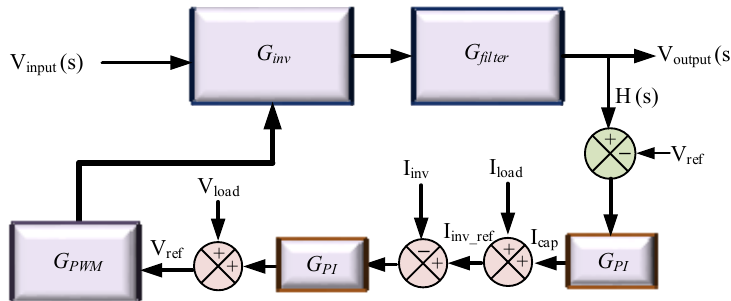
Figure 6. Block diagram representation of the proposed inverter system.